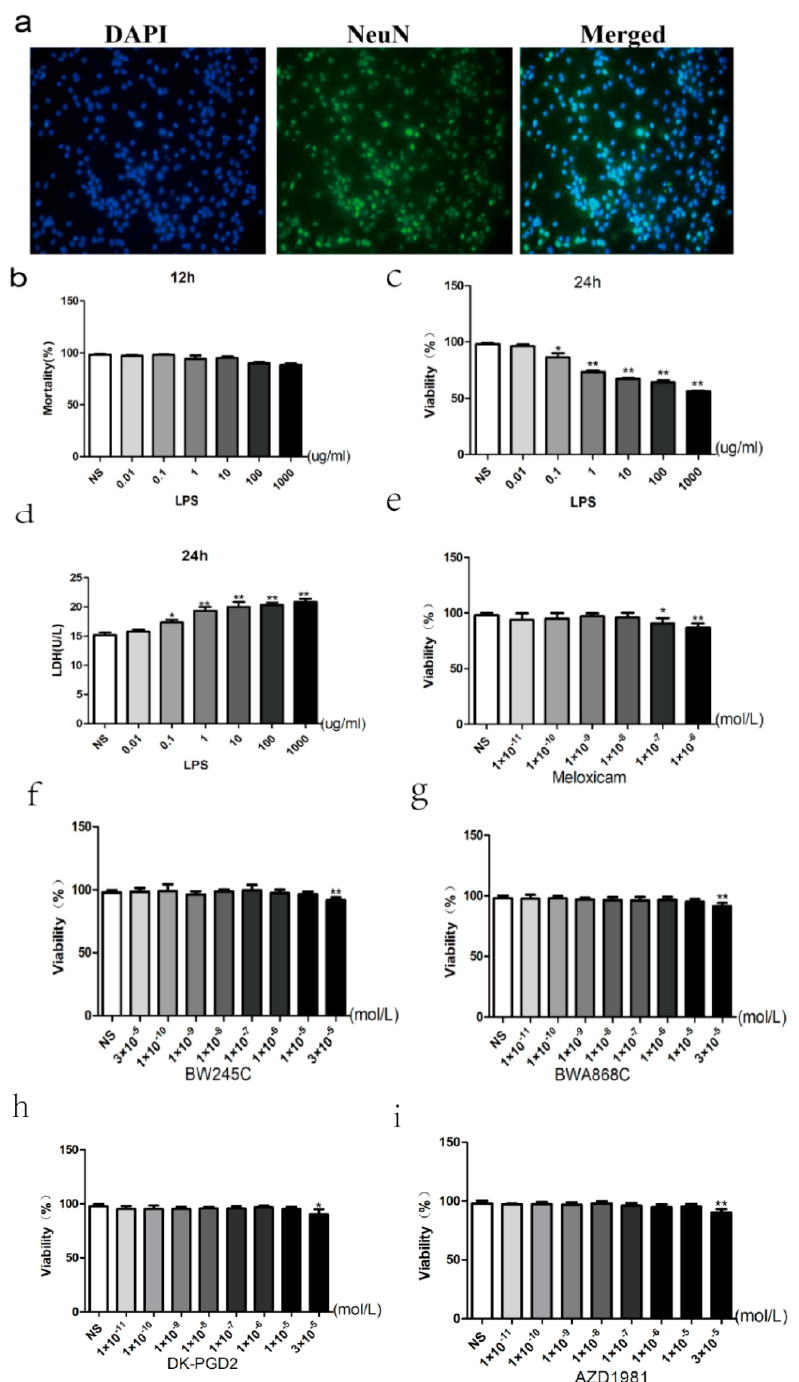
Figure 6. ( a ) Primary cultured and identification of neurons. ( b , c ) The effect of LPS on primary neu- rons. With the incremental concentration of LPS (12/24 h), the severe damage has been caused, and we also chose 1 ug/mL for the establishment of the damage model. ( d ) The change of LDH leakage rate intervened with LPS. ( e ) Meloxicam safety assessment. ( f ) BW245C safety assessment. ( g ) BWA868C safety assessment. ( h ) DK-PGD2 safety assessment. ( i ) AZD1981 safety assessment. Data is mean ± SEM, n = 6. (* p < 0.05, ** p < 0.01 vs. NS group)